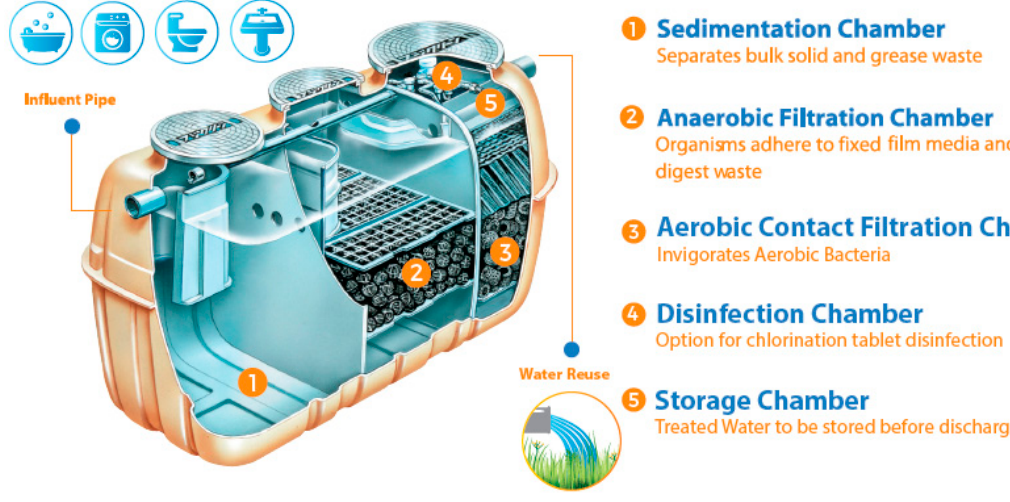
Figure 3. On-site wastewater treatment unit diagram [32].